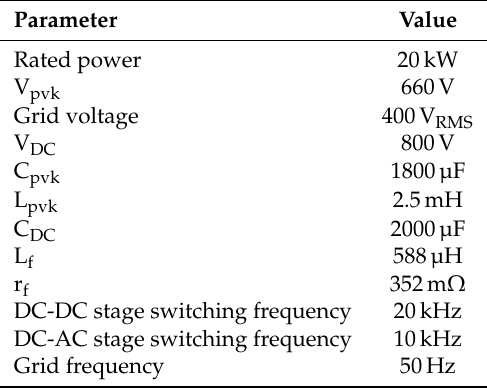
Table 2. Parameters of the proposed